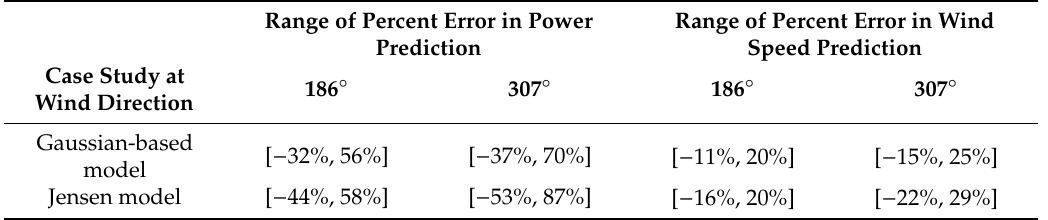
Table 4. Range of percent error in power and wind speed prediction for individual turbine within the wind farm.